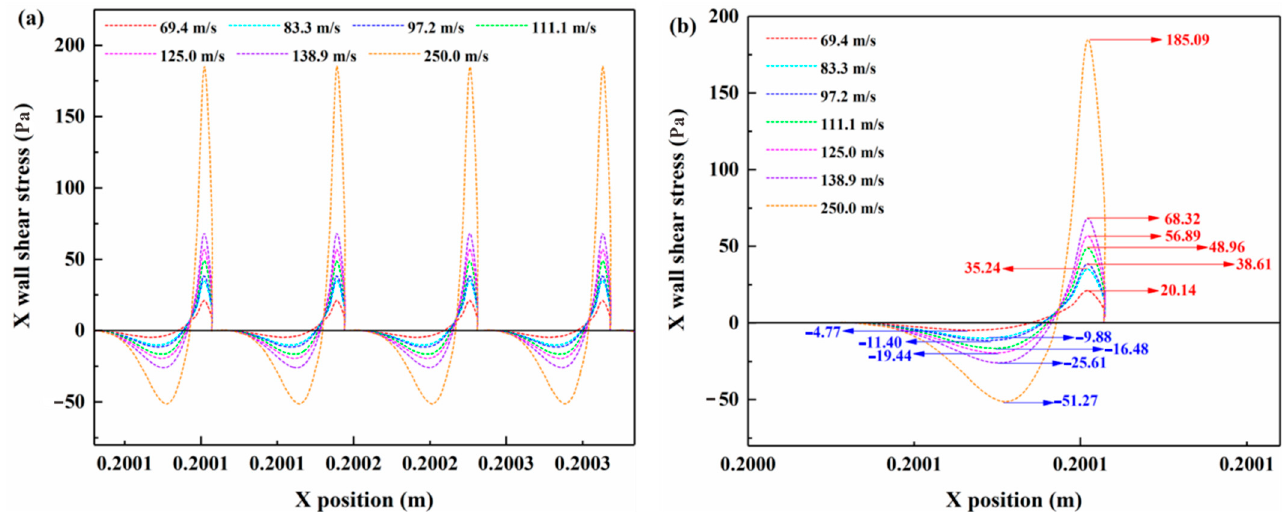
Figure 7. Wall shear stress of microstructure unit under different flow velocity conditions in X direction, ( a ) wall shear stress of 4 microstructure units, ( b ) a single wall shear stress unit with accurate values.